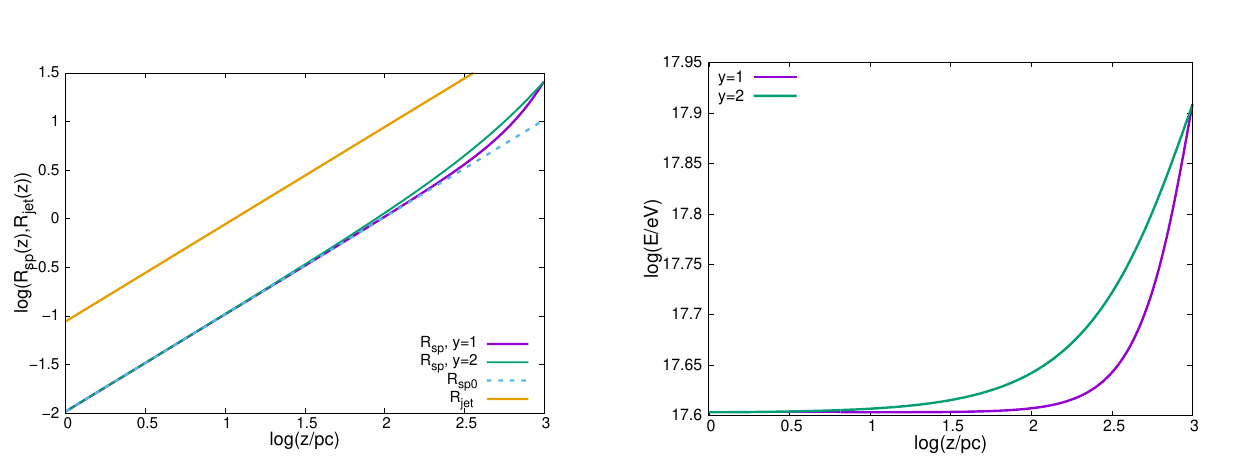
Figure 3. Comparison of R sp ( z ), R 0 ( z ), and R jet ( z ). For the Figure 5. Hillas energy at the shocks along the jet considering sp distribution of stars we adopt the expression given in Eq. 4 for the stellar population given by Eq. 4 and Z = 1 M BH = 10 8 M ⊙ and η accr = 0 . 1